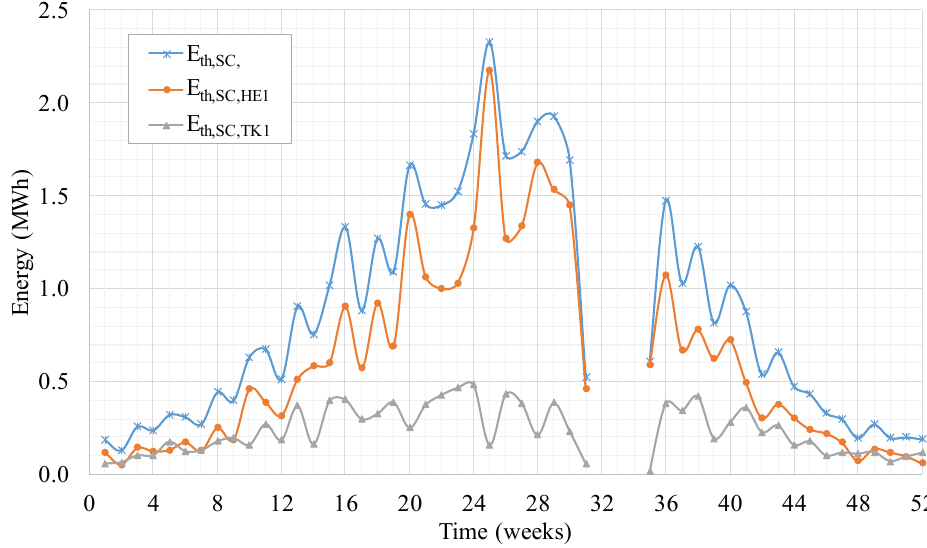
Figure 9. Solar thermal energy produced by the solar collectors and supplied to the swimming pool heat exchanger and solar collector tank—evacuated tube collectors, weekly analysis.